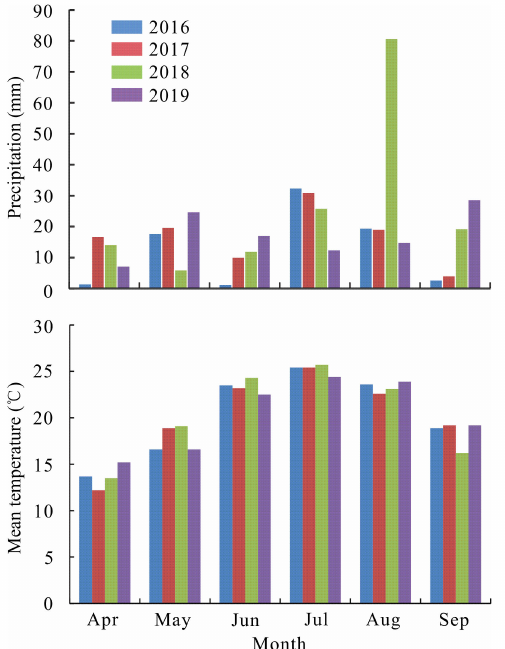
Figure 1. Monthly precipitation and mean temperature at Minqin Experimental Station of Lanzhou University during the growing seasons (April to September) from 2016 to